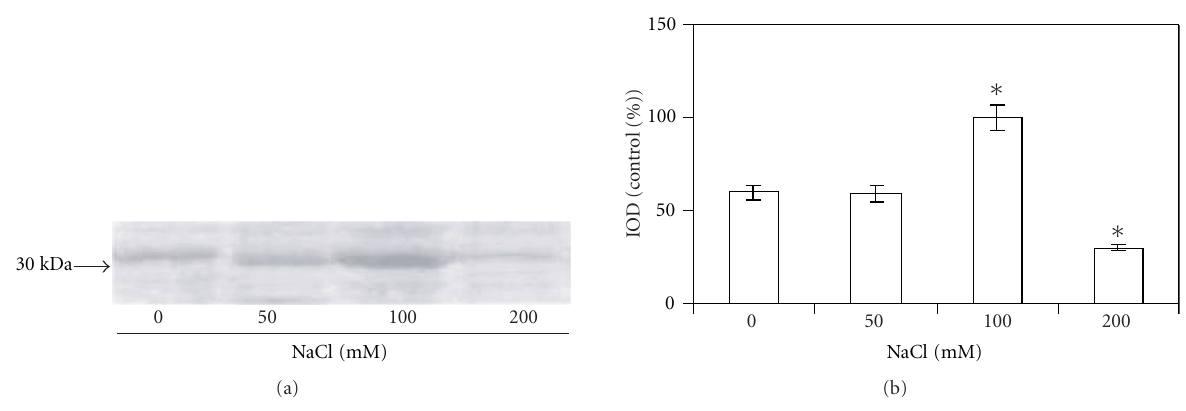
Figure 3: HO-1 protein expression in soybean leaves exposed to di ff erent NaCl concentrations (50, 100, or 200 mM) during 10 days. (a) HO- 1 protein expression was analyzed by Western blotting as described in Section 2. (b) Densitometry was done by Gel-Pro analyzer to quantify HO-1 protein expression Values are the mean of four independent experiments and bars indicate SD, ∗ significant di ff erences ( P < . 05) compared to control, according to Tukey’s multiple range